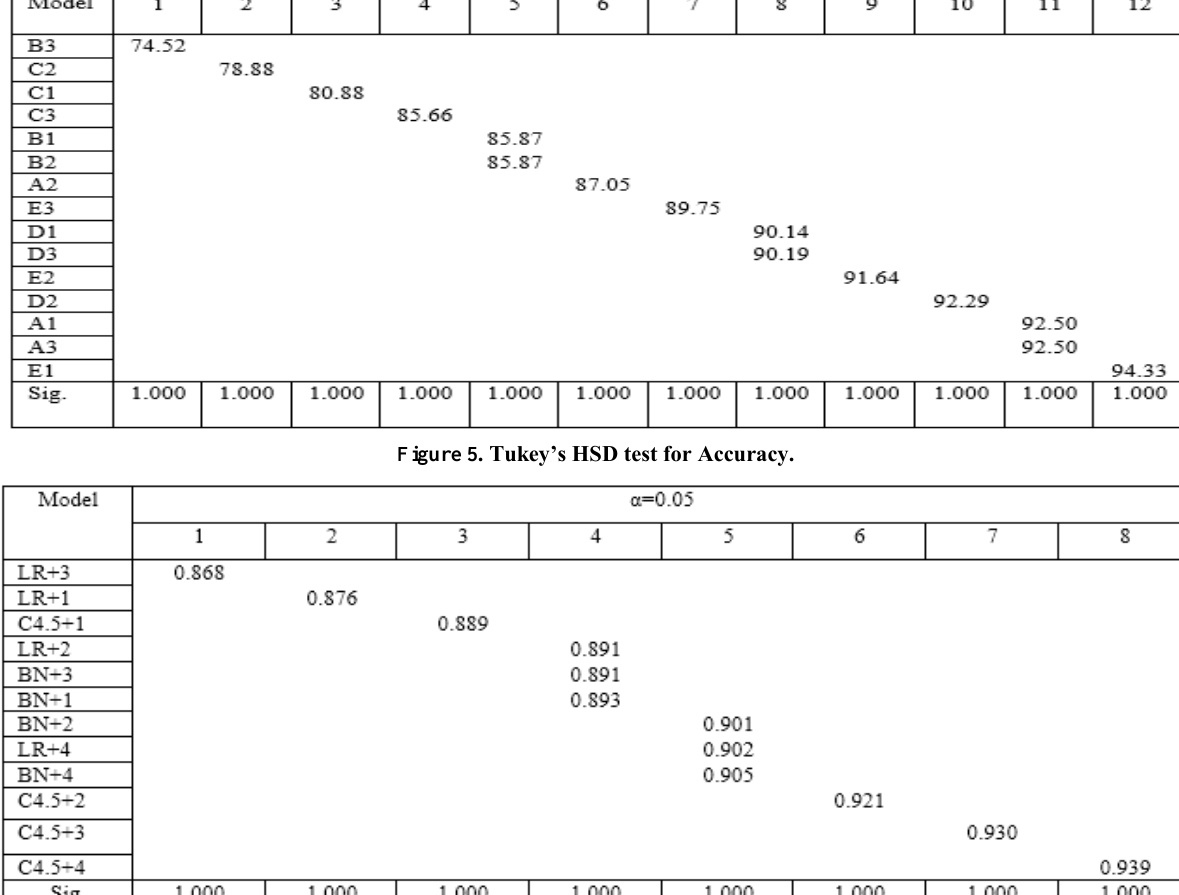
Figure 4. Tukey’s HSD test for Specificity.